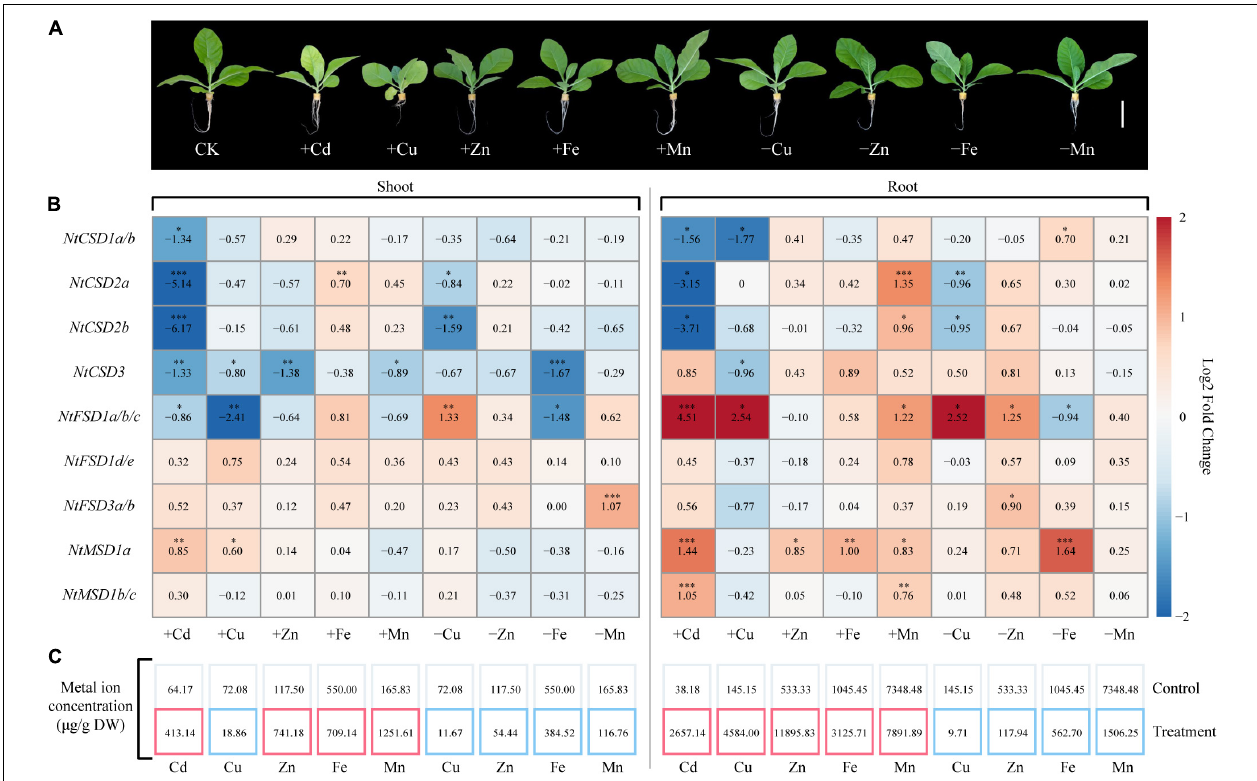
FIGURE 7 | Expression of NtSOD genes in tobacco shoots and roots treated with Cd, Cu, Zn, Fe, or Mn stress and without Cu, Zn, Fe, or Mn. (A) The phenotypes of tobacco seedlings subjected to different heavy metal treatments. (B) qRT-PCR analysis of NtSOD gene expression in response to various heavy metal stresses. The numbers in the box represent the average ratio of gene expression levels in the treatment and control groups. The asterisks on the number indicate significant differences (Dunnett’s test, * p < 0.05, ** p < 0.01, and *** p < 0.001). The population size was n = 3. (C) Content of metals contained in tobacco tissues subjected to different heavy metal treatments. The red box indicates that the corresponding metal content is higher than that of the control, while the blue box indicates that the corresponding metal content is lower than that of the